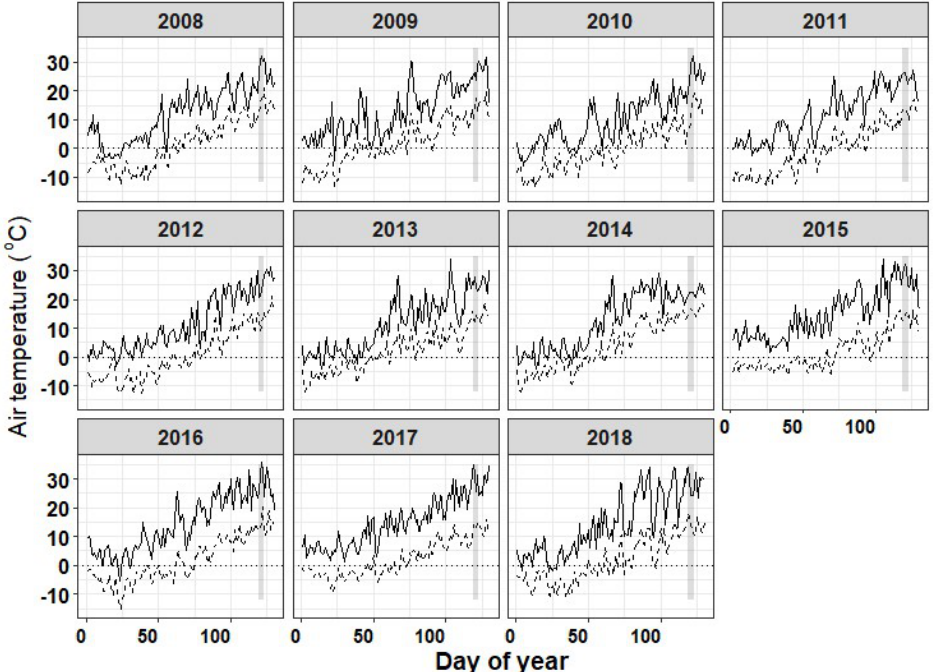
Figure 2. Maximum (full black line) and minimum (dotted black line) air temperature recorded at the Wangzhaung village from 2008 to 2018 from January to mid-May. The horizontal dotted line represents the 0 °C threshold while the vertical grey box represents the time when satellite images were acquired.